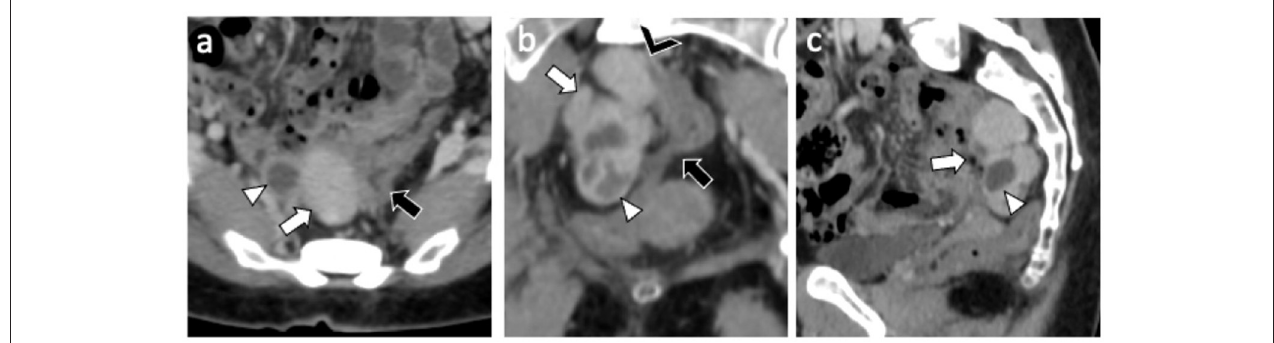
FIGURE 1 | CE-CT exam: Axial (a) coronal (b) and sagittal (c) CE-CT images shows a 6cm × 4cm multilobed mass (white arrow) characterized by both solid (Hyperdense) and cystic (hypodense) component (white arrowhead) with homogeneous enhancement and close proximity (black arrowhead) to sigmoid wall (black arrow).